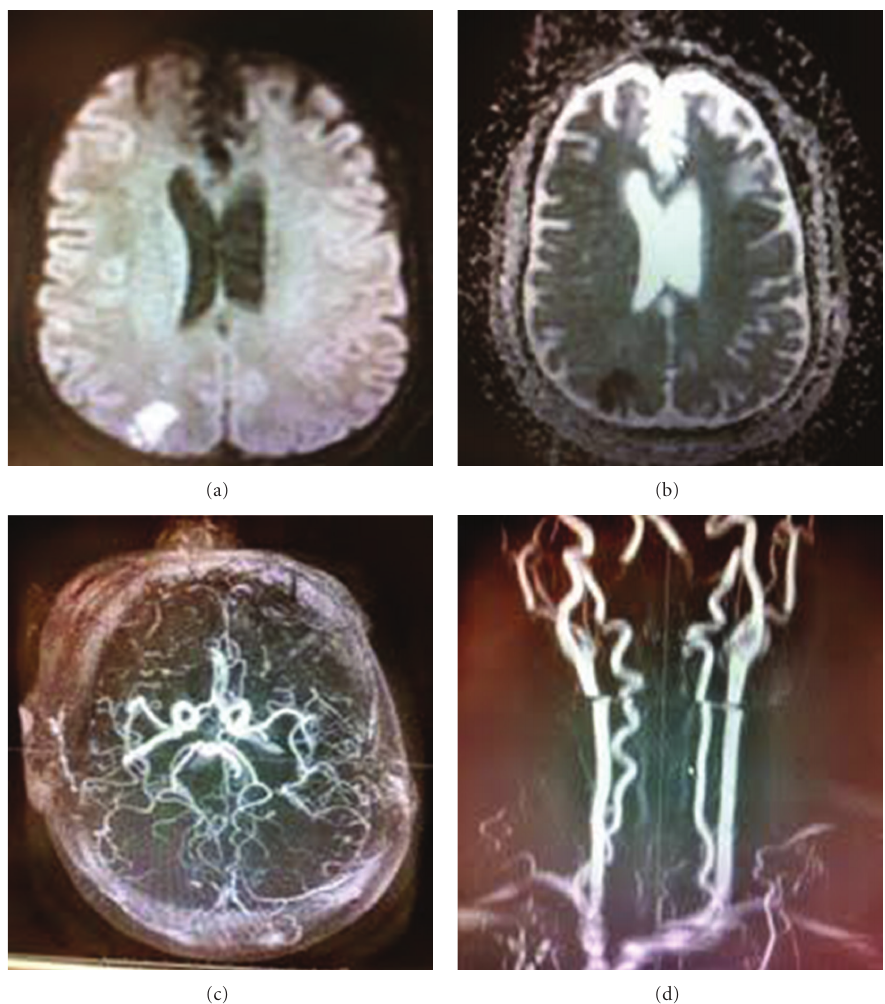
Figure 2: MRI Brain (a) DWI showing hyperintense lesion in the right MCA territory. (b) ADC showing mismatch in the same region confirming acute infarction. (c) and (d) MRA showing no evidence of thrombus formation or carotid